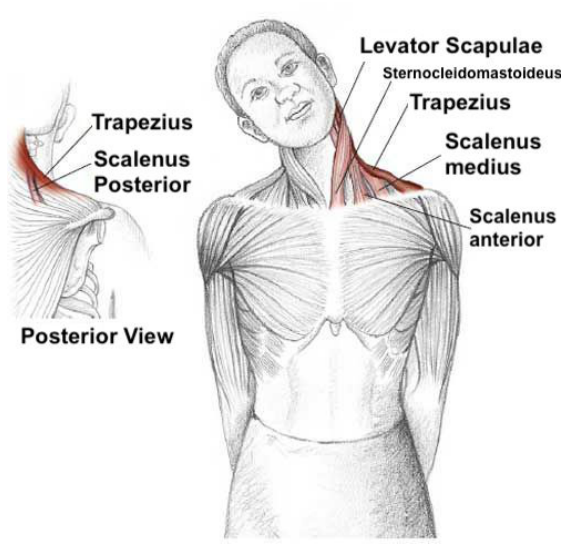
Figure 10. Lateral Neck Stretch: Main Neck and Shoulder Muscles.